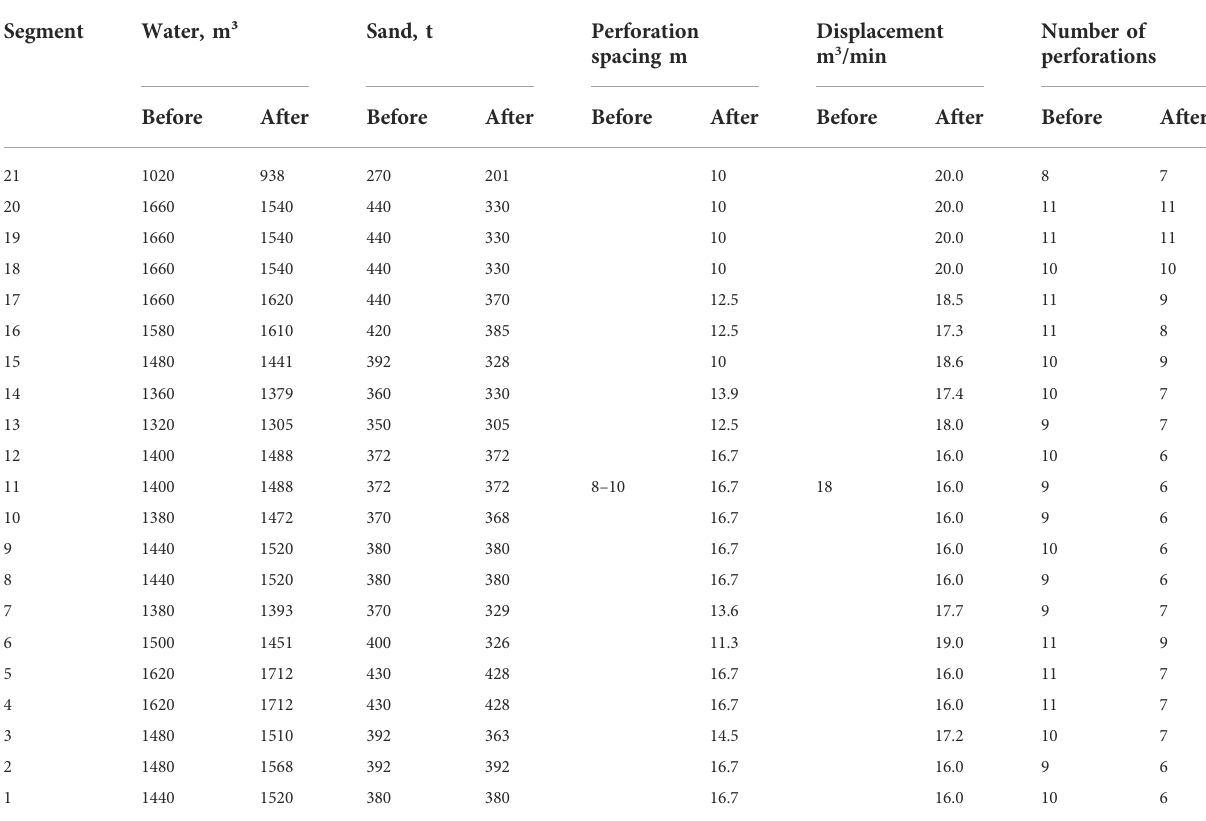
TABLE 2 Fracturing construction parameter optimization